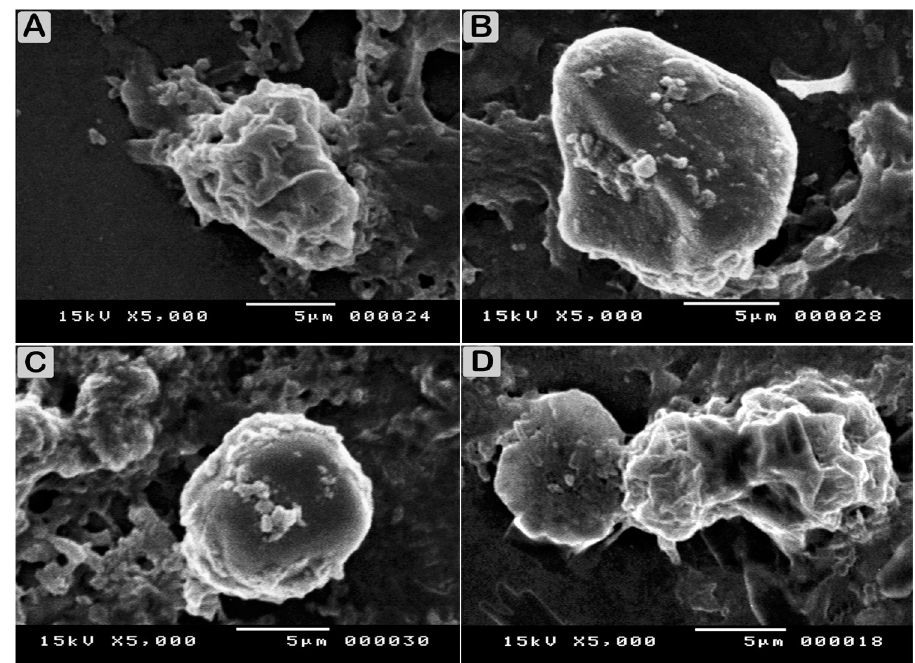
Fig 3. Scanning electron micrograph showing morphological stages of A . castellanii . (A) Trophozoite with the characteristic acanthopodia. (B and C) Phases of cyst wall formation as detected by scanning electron microscopy showing precyst with cellulose patches on the cell surface. (D) Mature cyst, the cyst wall appears completely formed and the wrinkled exocyst is clearly detectible.